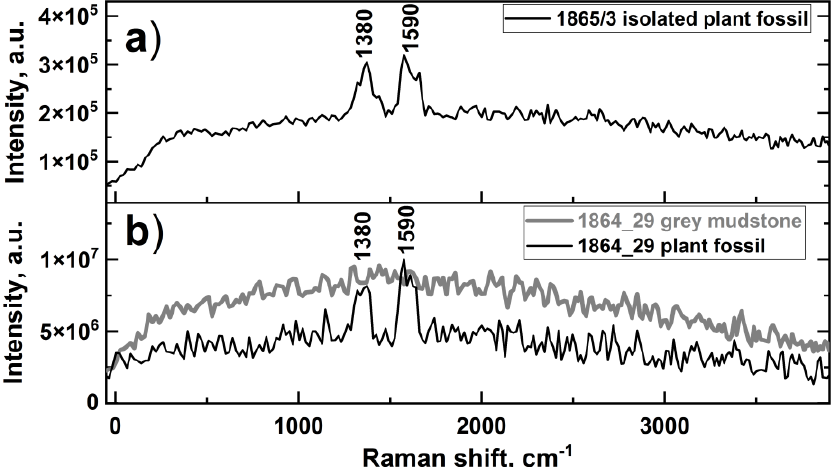
Figure 6. Pulsed Raman spectra of fossilized sample 4734_67 and 1864_29 samples measured by LIDAR with 532 nm excitation. Spectra are summed for 1000 laser pulses to improve sig- nal-to-noise ratio.